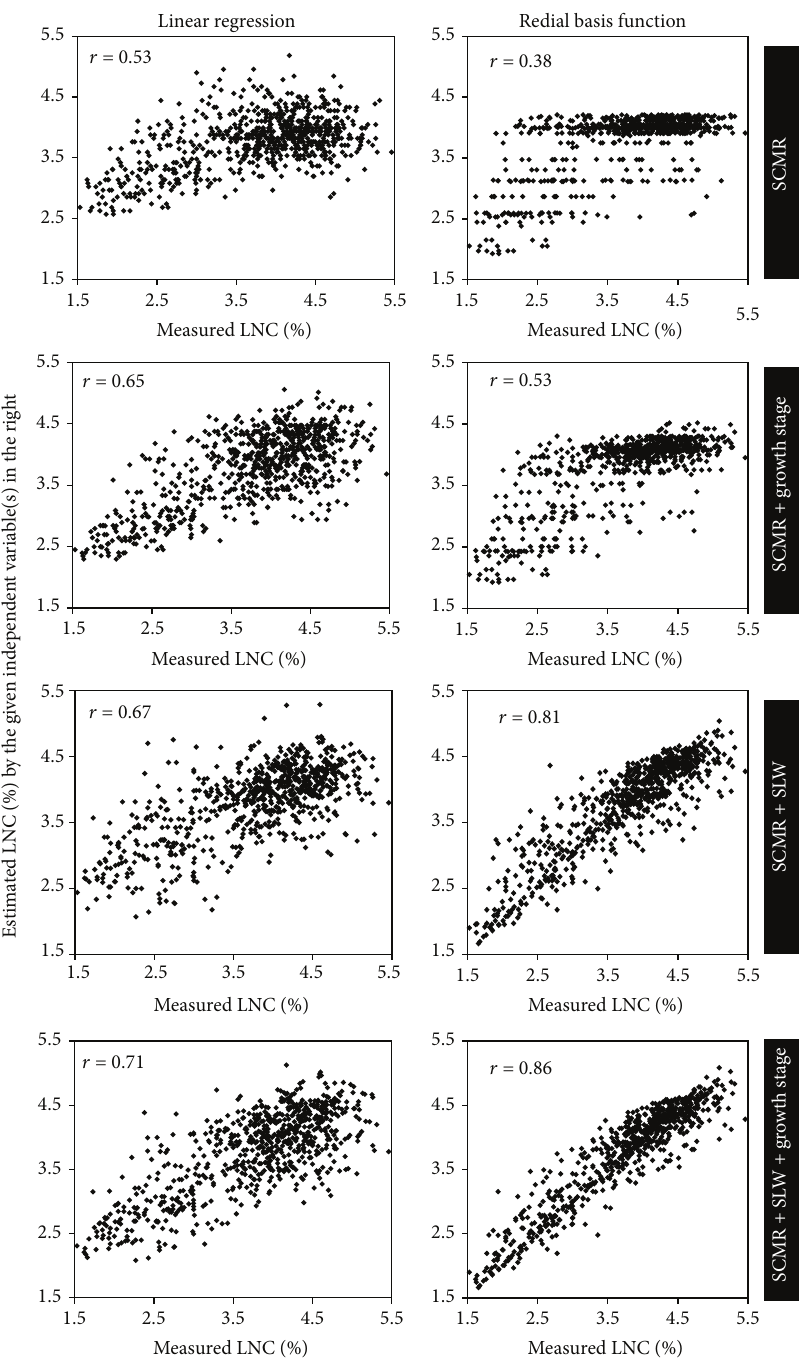
Figure 2: Association of estimated leaf N concentration (LNC) by linear regression (left) and nonlinear redial basis function (RBF) neural networks models (right) against actual LNC values. Data from two trials, two years, and three growth stages. Variables in the right side represent the combination of independent variables that generated each